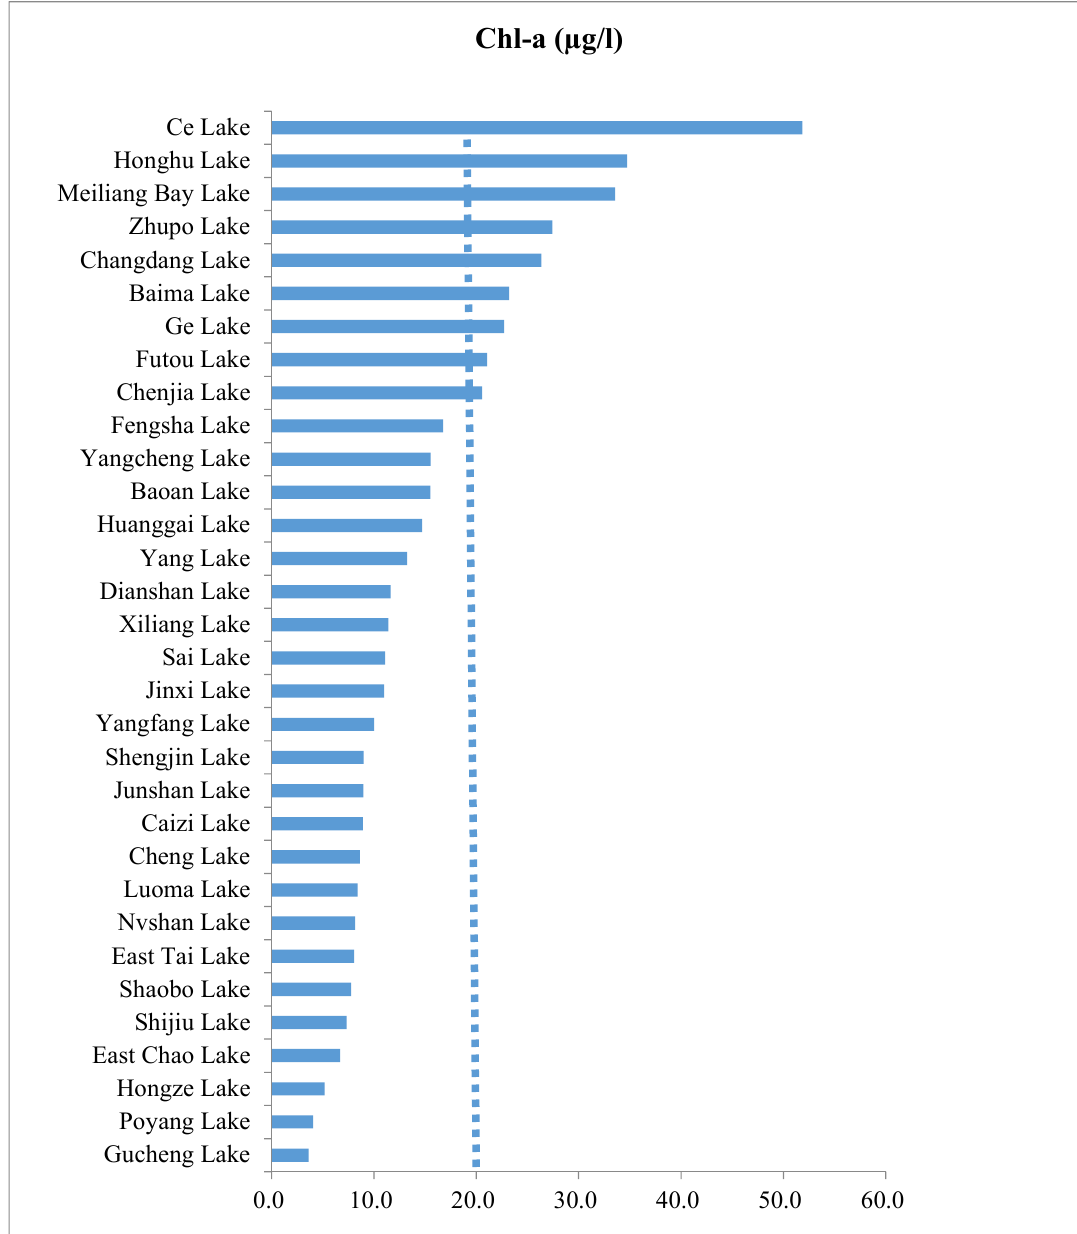
Figure 4. Gradient of water quality with TP pollution in 32 study sites. Total phosphorous concentration > 0.026 µg/L is shown by the vertical line, i.e., eutrophic and hypertrophic lakes. Lakes are presented on the basis of the smallest to the largest measurements of TP.